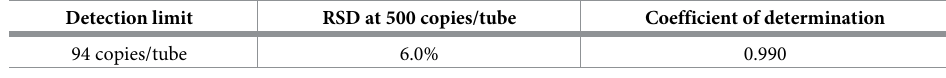
Table 1. Experimental parameters in RNA analysis.